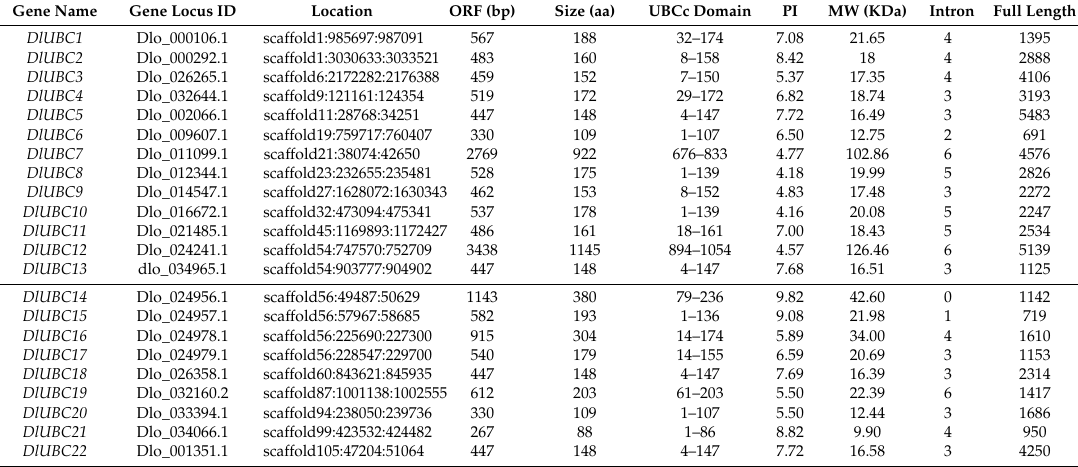
Table 1. The information of DlUBC gene